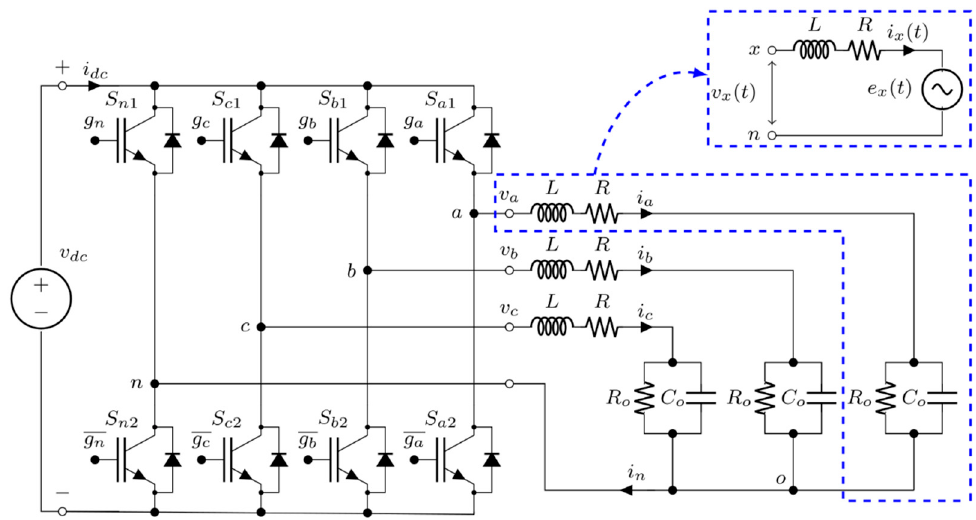
Figure 3. Circuit scheme of a four-leg, three-phase VSC supplying unity power factor load emulating the AC grid (AC-link inductors are independent).